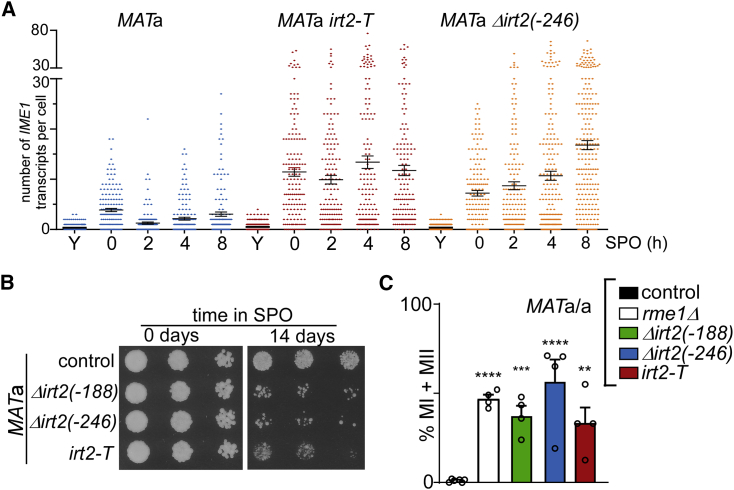
Transcription of IRT2 prevents meiotic entry in cells with a single mating type(A) IME1 expression in single cells, as measured by single-molecule RNA fluorescence in situ hybridization (FISH). MATa control, Δirt2(−246), and irt2-T (FW1533, FW3580, and FW3585) cells. The strains used also harbored a flo8 deletion. Formaldehyde-fixed cells were hybridized with probes directed against IME1 and ACT1. Each dot represents the number of IME1 transcripts in a single cell positive for ACT1 expression. Error bars represent SEM; n = 150 cells.(B) Spot assay of cells on rich medium agar plates in 5-fold serial dilutions after 0 or 14 days in SPO. MATa control, Δirt2(−188), Δirt2(−246), and irt2-T cells (FW1509, FW1210, FW1356, and FW3596).(C) MATa/a diploid control cells (FW15) and cells harboring rme1Δ, Δirt2(−188), Δirt2(−246), or irt2-T (FW1317, FW3453, FW3402, and FW3629) were grown as described in (A). DAPI masses were counted from cells fixed at 72 h in SPO. Cells harboring >2 DAPI masses were considered to have undergone meiotic divisions (MI + MII). Error bars represent ±SEM; n = 4, except for the control sample (n = 6). ∗∗p < 0.005; ∗∗∗p < 0.0005; and ∗∗∗∗p < 0.0001, on a one-way ANOVA followed by Fisher’s LSD test.